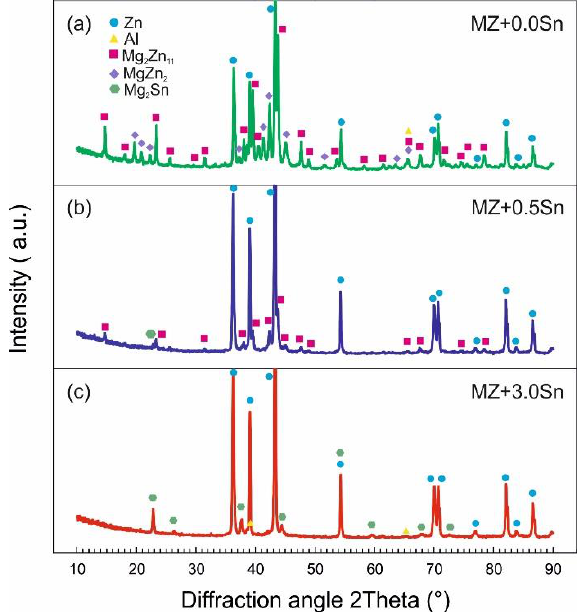
Figure 5. XRD diffraction patterns recorded on powder samples of selected alloys in as-cast state ( a )